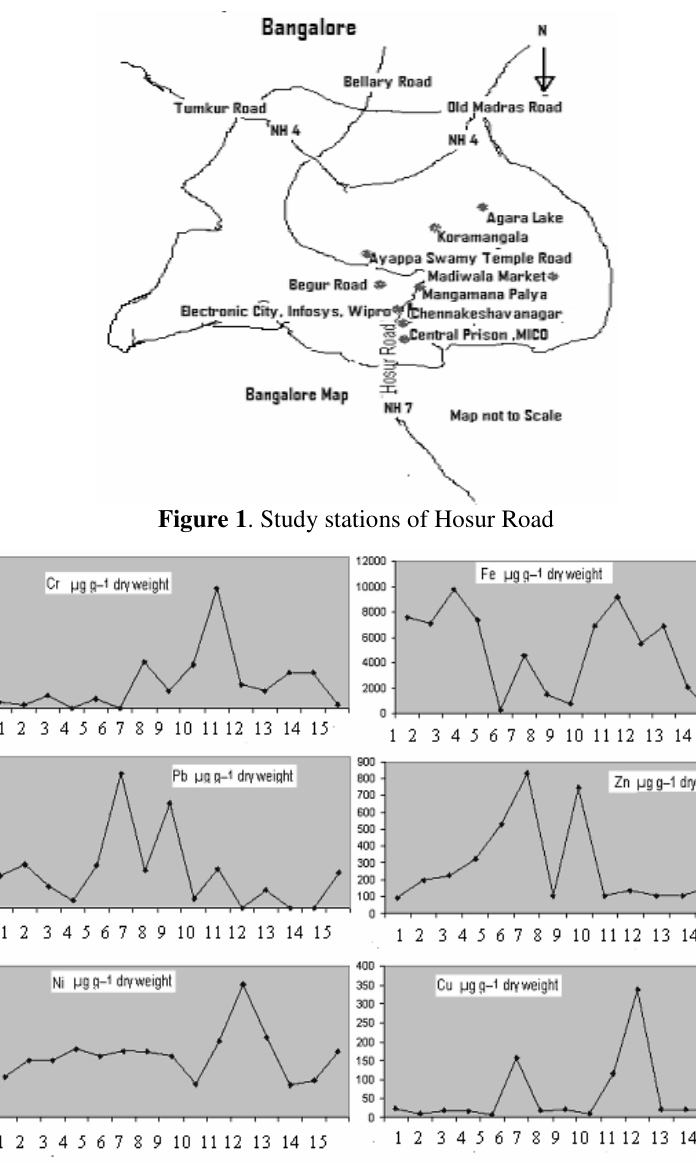
Figure 2 . Heavy metal concentration µg g -1 dry weight in litchens species at various localities* in Hosur